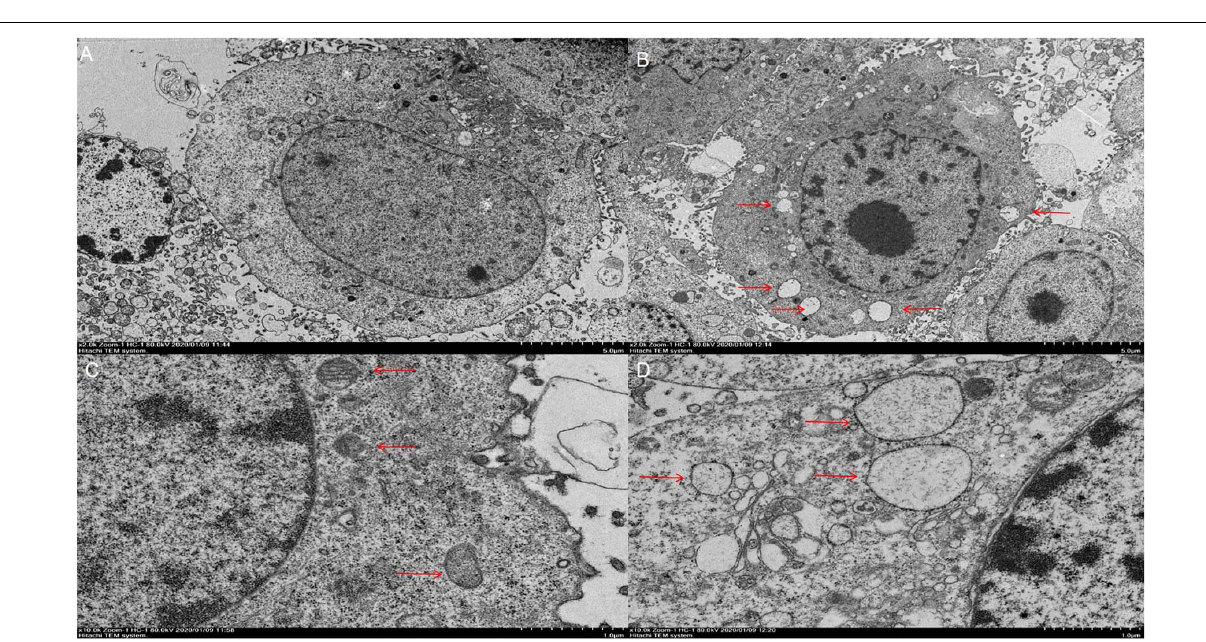
FIGURE 3 | Results of cell electron microscopy. (A) Control cells at 5,000 × magnification. (B) Challenge group cells amplified at 5,000 × . (C) Control cells at 10,000 × magnification, with the arrow pointing to the endoplasmic reticulum. (D) Cells in the challenge group at 10,000 × magnification. The arrow indicates the endoplasmic reticulum with abnormal